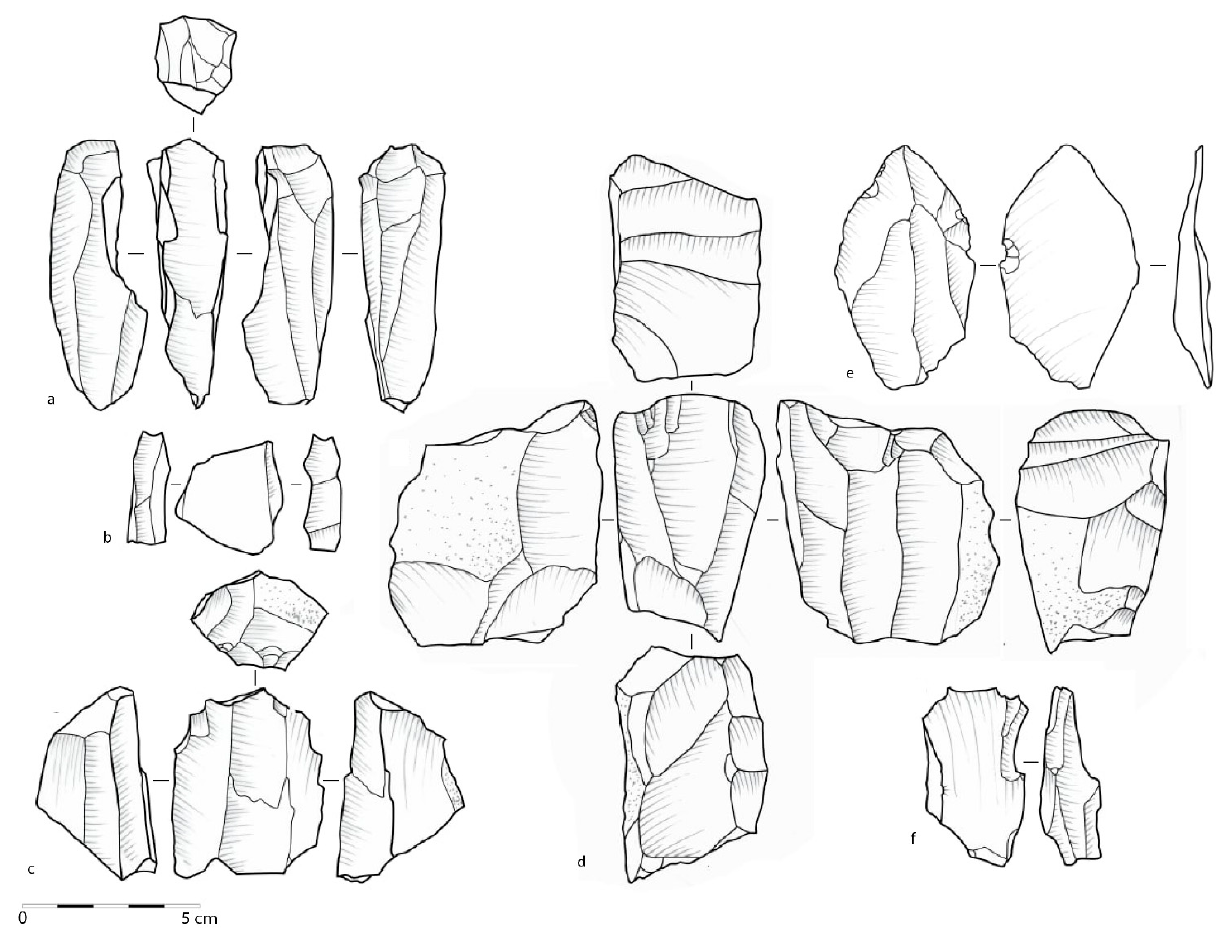
Figure 9. Lojanik 2, lithic artefacts from previous surveys: ( a , c , d ) blade cores; ( b , f ) burin cores; ( e ) laminar flake.